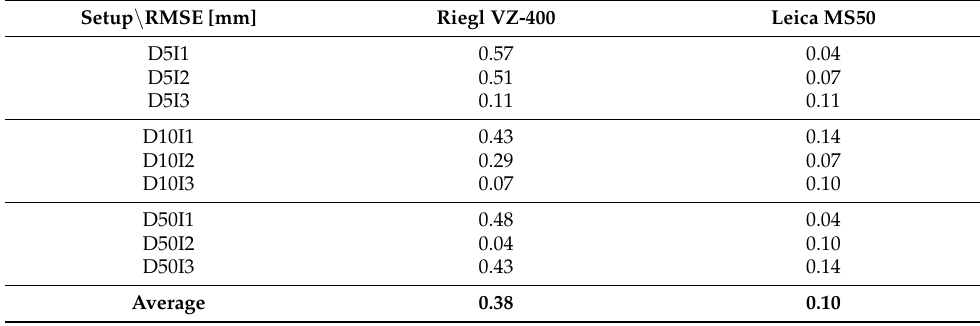
Table 2. The accuracy of detected shifting declinations: RMSE